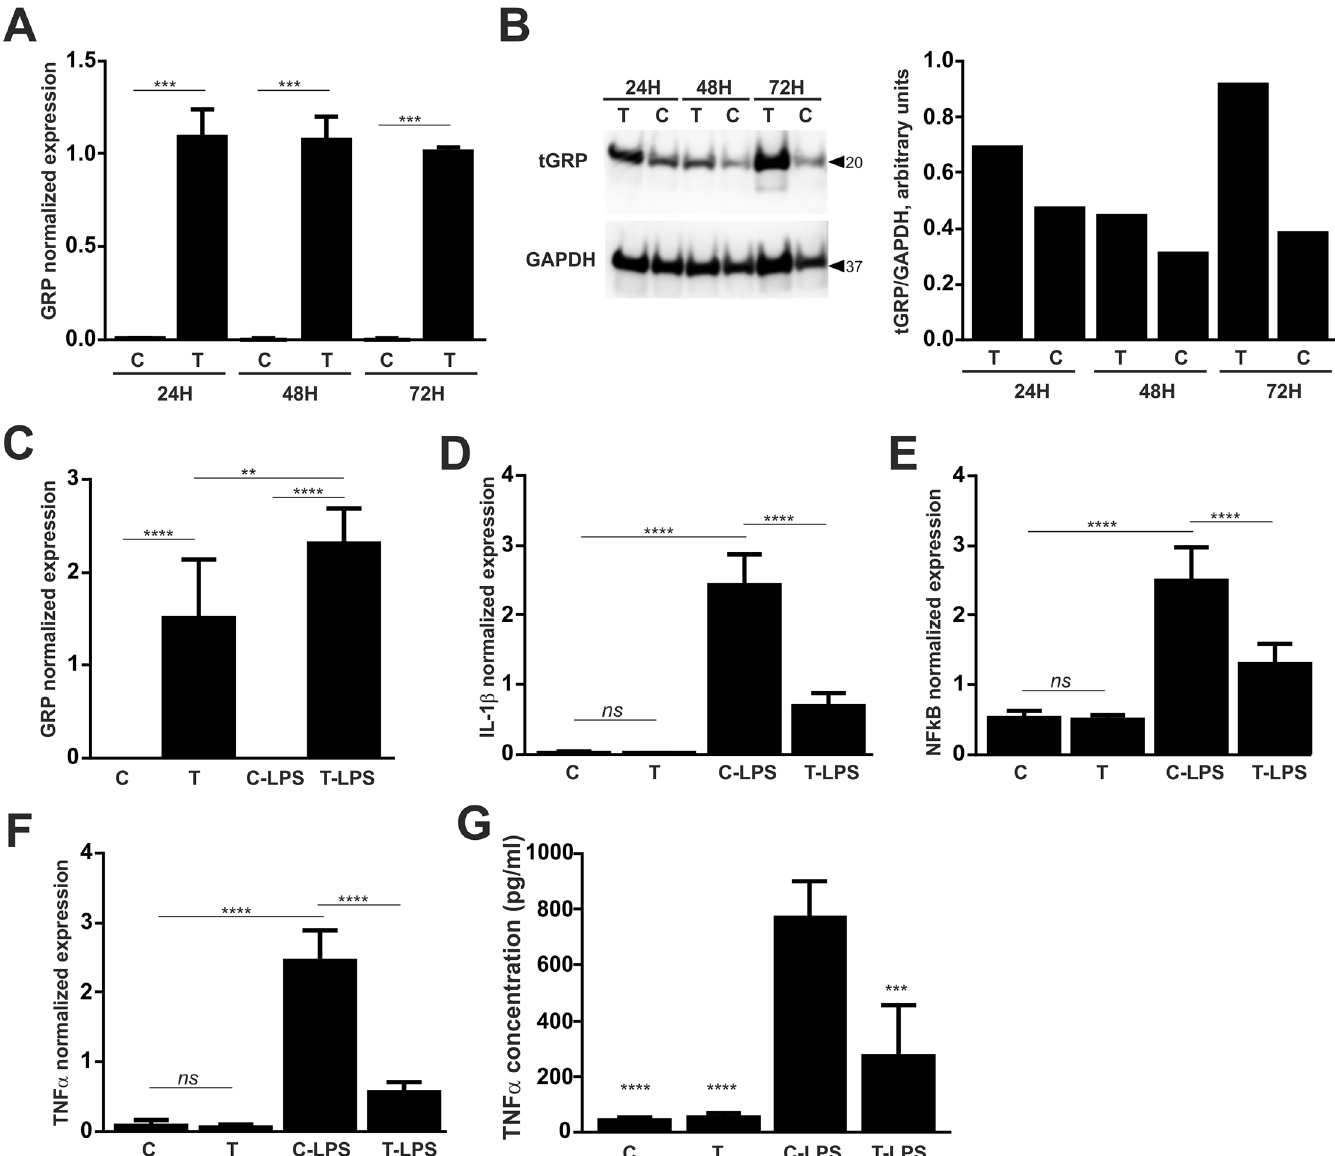
Fig 7. Overexpression of GRP in THP-1 cells rescues LPS induced inflammation. THP-1 cells were transientlytransfected with GRP mRNA during24, 48 and 72 h, and GRP overexpression was evaluatedby measuring levels of GRP mRNA (A) and protein production (B). (A) GRP Normalizedexpression was determined by qPCR in non-transfected (C) and transfected (T) cells at the indicatedtime points. Data are presentedas means (n = 3) ± standard error of duplicates of two independentexperiments. Student’st-test was used for comparisonbetweenC and T groups at each time point. Statistical significance was definedas P < = 0.001 ( *** ). (B) Twenty micrograms of total protein extracts from the conditionsdescribedabovewere analysedby Western blot to detect tGRP and GAPDH proteins, and relative protein levels normalizedto GAPDH were obtainedusing ImageJ software and are presentedas arbitrary units. (C-G) Transfected (T) and non-transfected THP-1 (C) cells were cultured for 24 h and either maintained in control conditions (C, T) or stimulatedwith LPS (C-LPS, T-LPS) for additional12 h. NormalizedGRP gene expressionwas determined by qPCR (C), and inflammatory responsewas evaluatedby measuring gene expressionof the inflammatory markers IL-1 β (D) NFkB (E) and TNF α (F) and TNF α accumulation in cell culture media by ELISA (G). (C-F) Data are presentedas means (n = 6) ± standarderror of triplicates of two independentexperiments. Ordinary one-wayANOVA was used and multiple comparisons were achievedwith Tukey’s test. Statistical significancewas definedas P < = 0.01 ( ** ), P < = 0.001 ( *** )and P < 0.0001( **** ). ns , non- significant.(G) Data is presentedas means (n = 4) ± standarderror of triplicates of two independentexperiments. Ordinary one-wayANOVA was used and multiplecomparisons were achievedwith Dunnett’s test. Statistical significancewas definedas P < = 0.001 ( *** )and P < 0.0001( **** ).